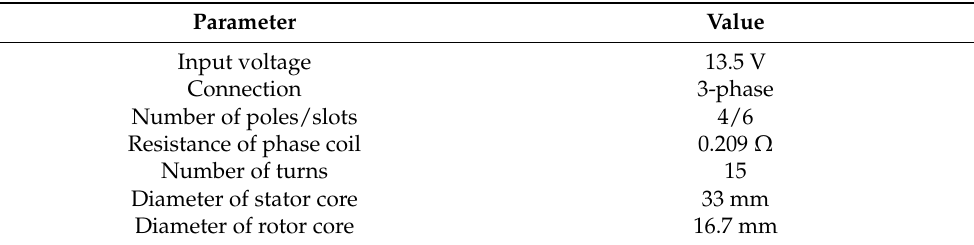
Figure 2. Design model of brushless direct-current (BLDC) motor: ( a ) isometric view model; ( b ) cross-section view model. Table 1. BLDC motor specifications.